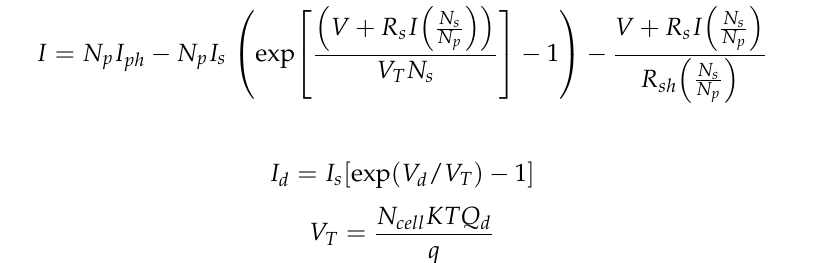
Figure 5. PV array model.